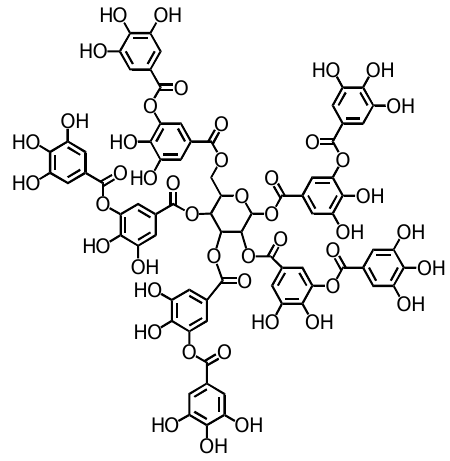
Figure 1. Molecular structure of tannic acid.